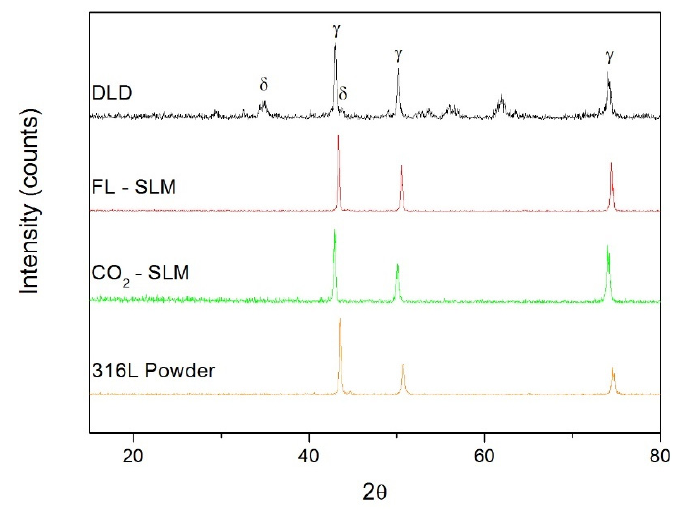
Figure 8. XRD of the samples made using different processes.